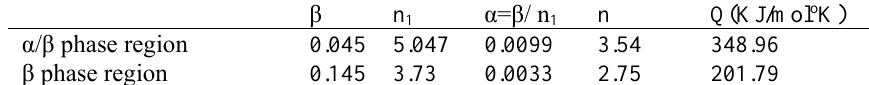
Fig. 7. Plot of the Zener–Hollomon parameter as a function of flow stress Table 1. Values of β, n1, α, Q of ATI425